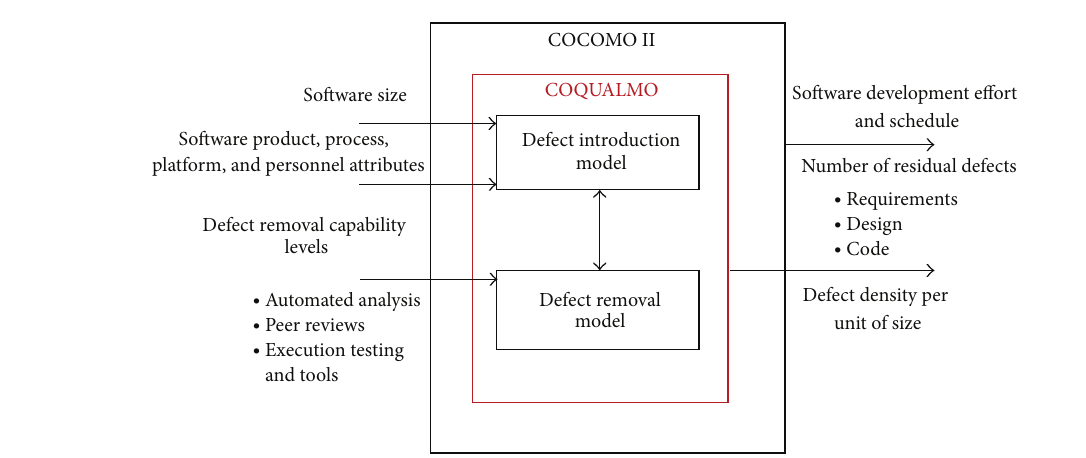
Figure 2: COQUALMO